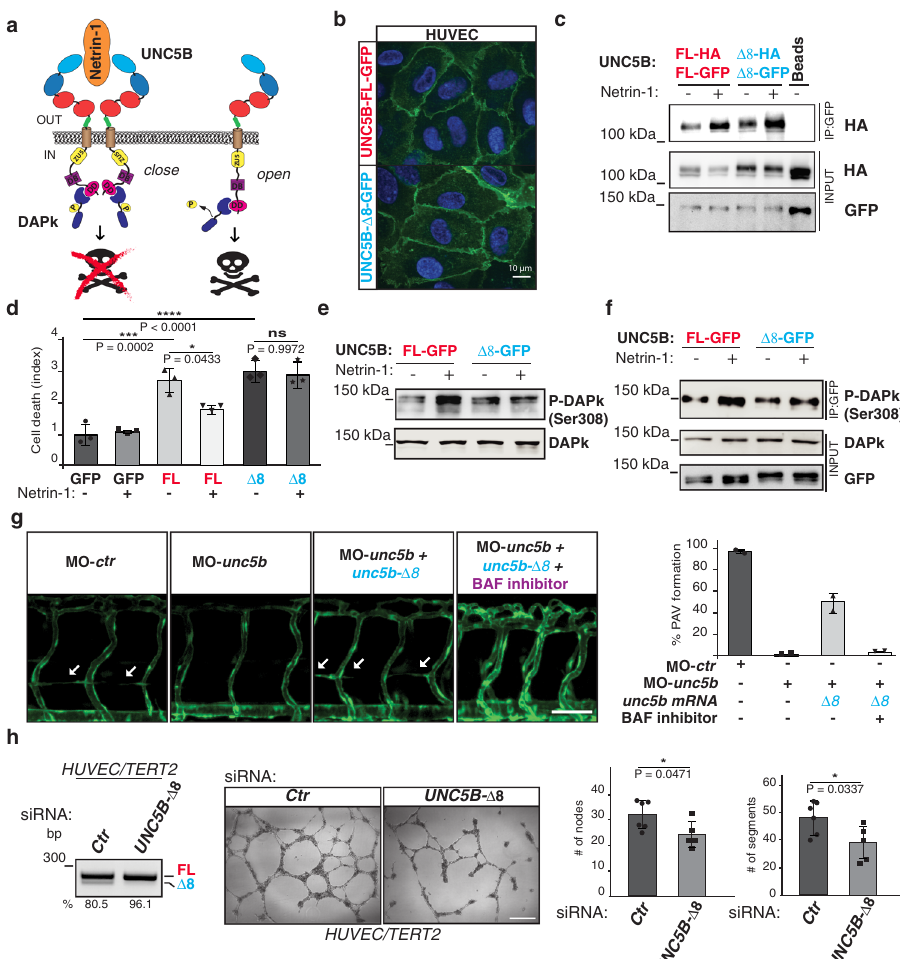
Fig. 4 UNC5B- Δ 8 prevents Netrin-1 prosurvival signaling and promotes vessel formation in an apoptotic-dependent manner. a Schematic representation of Netrin-1/UNC5B-mediated prosurvival signal. UNC5B domains are indicated with different colors. Blue ovals: Ig-like domains; red ovals: thrombospondin-like domains (TSP1); beige cylinder: transmembrane domain (TM); yellow circle: ZU5 domain; violet cube: UPA/DCC-binding domain (DB); pink circle: death domain (DD). Region encoded by exon 8 is shown in green. Netrin-1 is in orange, whereas DAPk is in dark blue. DAPk phosphorylation at Ser308 is indicated. b Localization of GFP-tagged UNC5B isoforms in HUVECs. Scale bar: 10 μ m. c Co-immunoprecipitation of UNC5B AS isoforms GFP-tagged with HA-tagged isoforms in the presence or absence of Netrin-1 (150 ng/ml). Unspeci fi c magnetic beads (Beads) as control. d Vital exclusion assay in HeLa cells overexpressing UNC5B AS isoforms or GFP as control. Error bars indicate ±SD; n = 3. One-way ANOVA for multiple comparisons. e DAPk phosphorylation (Ser308) was evaluated in HeLa cells co-transfected with plasmids expressing DAPk and Unc5b isoforms with or without Netrin-1 treatment (150 ng/ml). Total DAPk as control. f Co-immunoprecipitation of Phospho-DAPk (Ser308) in HeLa cells transiently transfected as in e . g Left: Lateral views ( fl uorescence) of 72 hpf zebra fi sh embryos expressing the GFP under the control of the endothelial-speci fi c promoter kdrl injected with a control morpholino (MO- ctr ) or with a morpholino against unc5b (MO- unc5b ); unc5b morphants were also co-injected with a morpholino- resistant zebra fi sh mRNA encoding for unc5- Δ 8 ( unc5b- Δ 8 ) and treated with a pan caspase inhibitor (BAF inhibitor). White arrows: forming PAV. Right: Quanti fi cation of PAV formation in the above zebra fi sh embryos, two different biological replicates were analyzed. n = 2. Error bars indicate ±SEM. Scale bar: 50 μ m. h HUVEC/TERT2 treated with a siRNA oligo against the UNC5B- Δ 8 mRNA ( n 5) or a control ( Ctr ) oligo ( n = 6) were analyzed (left) by RT- PCR for UNC5B exon 8 splicing and (center) for the formation of capillary tube-like structures on Matrigel. Right: quanti fi cation of nodes and segments (# per fi eld) in the in vitro tube formation assay. Two-tailed Student ’ s t -test. Error bars indicate ±SD. n = biologically independent experiments. Exact P values are indicated: * P < 0.05;; *** P < 0.001; **** P < 0.0001; ns not signi fi